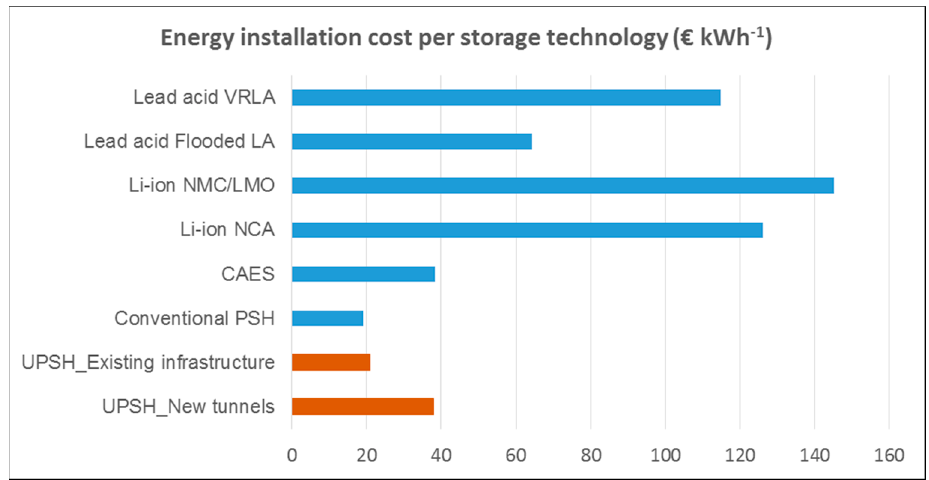
Figure 7. Energy installation cost of battery storage technologies vs. UPSH plants.